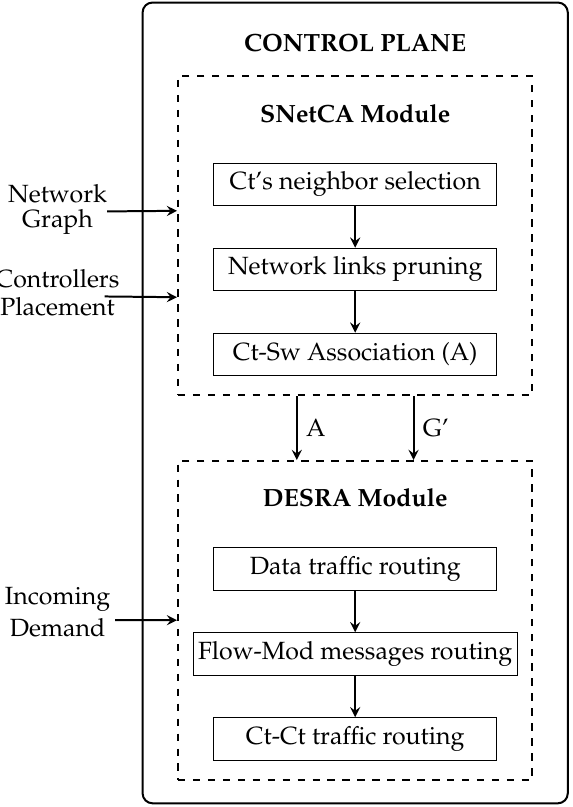
Figure 1. Illustrative diagram of the proposed approach. SNetCA, Static Network Configuration Algorithm; DESRA, Dynamic Energy Saving Routing